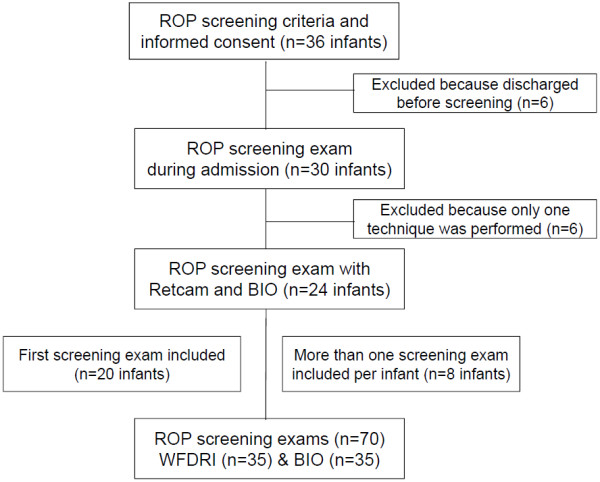
Flow diagram of the study participants. Abbreviations: ROP, Retinopathy of prematurity; WFDRI, wide-field digital retinal imaging; BIO, binocular indirect ophthalmoscope.